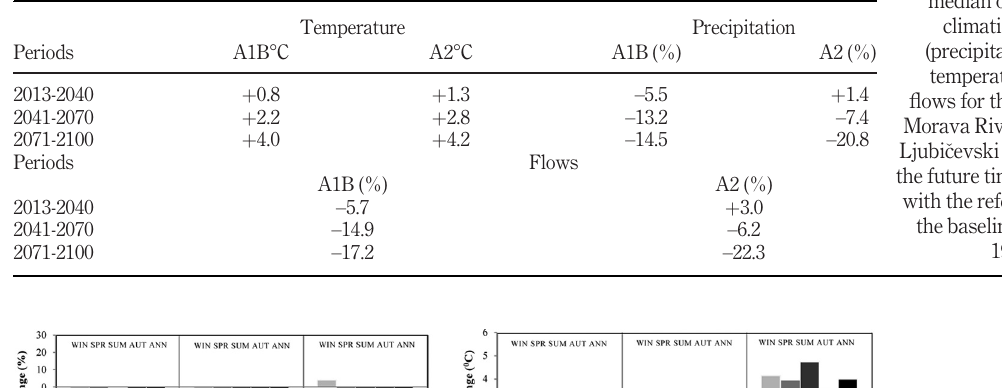
Figure 2. Relative changes in the median of seasonal precipitation (a, b) and absolute change in the median of seasonal temperature (c, d) for the Velika